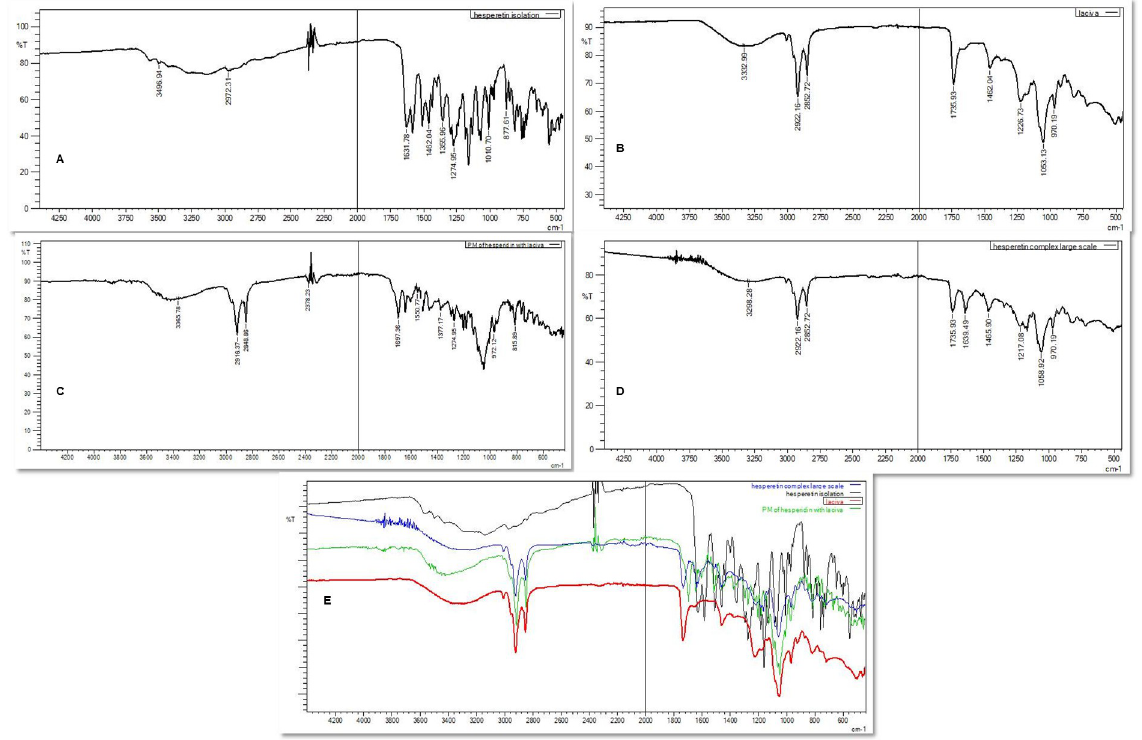
Fig 2. FT-IR spectra of HT (A), PC (B), PM (C), HTN (D), and overlay spectrum